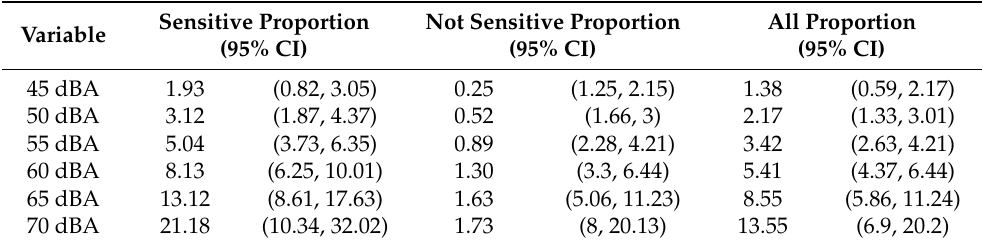
Table A15. L Night and marginal proportions of sleep disturbance by road noise in the weighted study sample, adjusted for sensitivity to noise: marginal prediction by